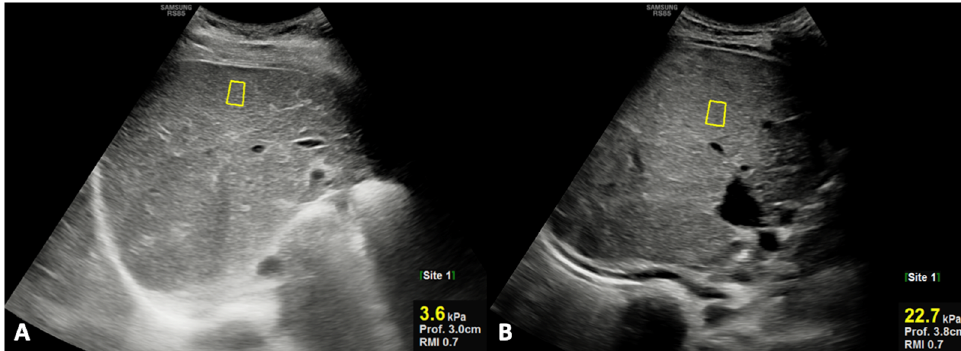
Figure 2. Ultrasound oblique scans under the right rib, showing shear-wave elastography measurements using ROI analysis in a patient of group 1 (( A ) #5; Table 1—liver stiffness = 3.6 kPa) and in a patient of group 2 (( B ) #11; Table 2—liver stiffness = 32.5 kPa).